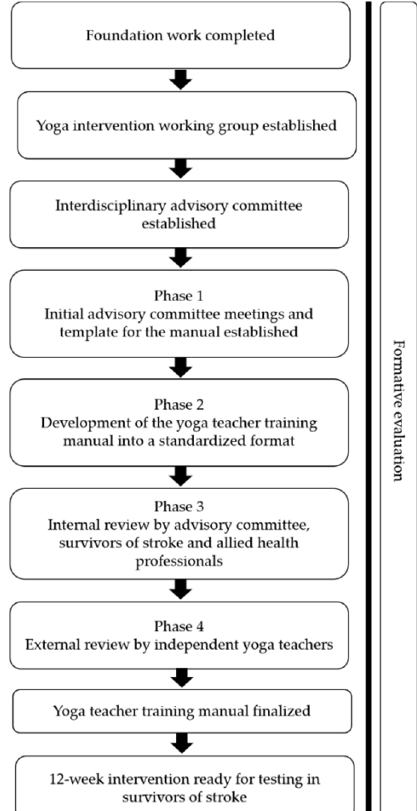
Figure 1. Summary of the processes.